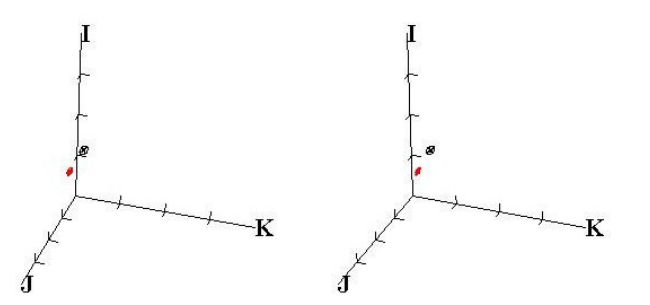
Figure 8. 95% confidence ellipsoids for the first subject in the RGP group. R1 is represented by the black ellipsoid and R2 is represented by the red ellipsoid. Data points were not included to enhance visibility of the confidence ellipsoids. The origin is 42.50 I D.